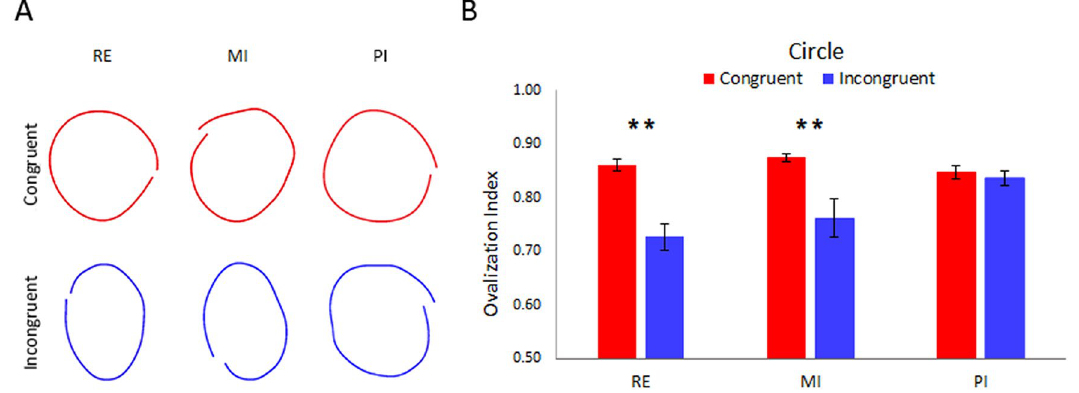
Figure 2. ( A ) Shows examples of a representative subject’s left-hand trajectory in the three protocols (Real - RE, Motor Imagery—MI and Proprioceptive Illusion—PI). Red circles represent the congruent condition (namely, when subject was performing/imagining/perceiving circles with their right hand, too). Blue circles represent the incongruent condition (namely, when subject was performing/imagining/perceiving lines with their right hand). It is noticeable the presence of ovalization in the incongruent condition in the RE and MI protocol but not in PI. The averaged Ovalization Indexes of the circle-drawings performed with the left hand in Real, MI and PI protocols during congruent (red bar) and incongruent (blue bar) conditions are represented in ( B ). The error bars refer to the standard error of the mean. *Refers to p < 0.05.